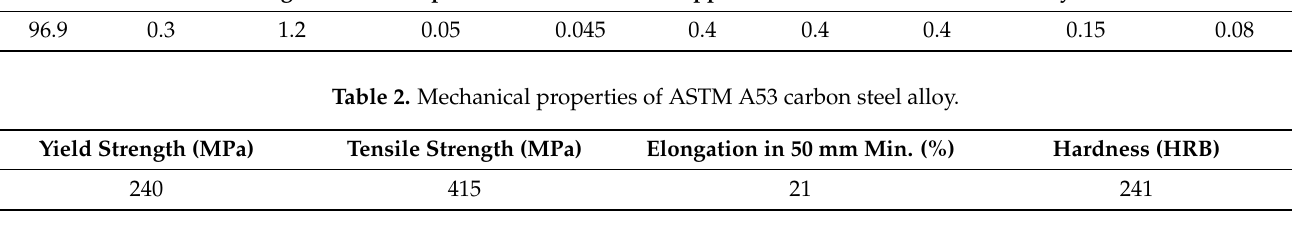
Table 3. Mechanical properties of glass